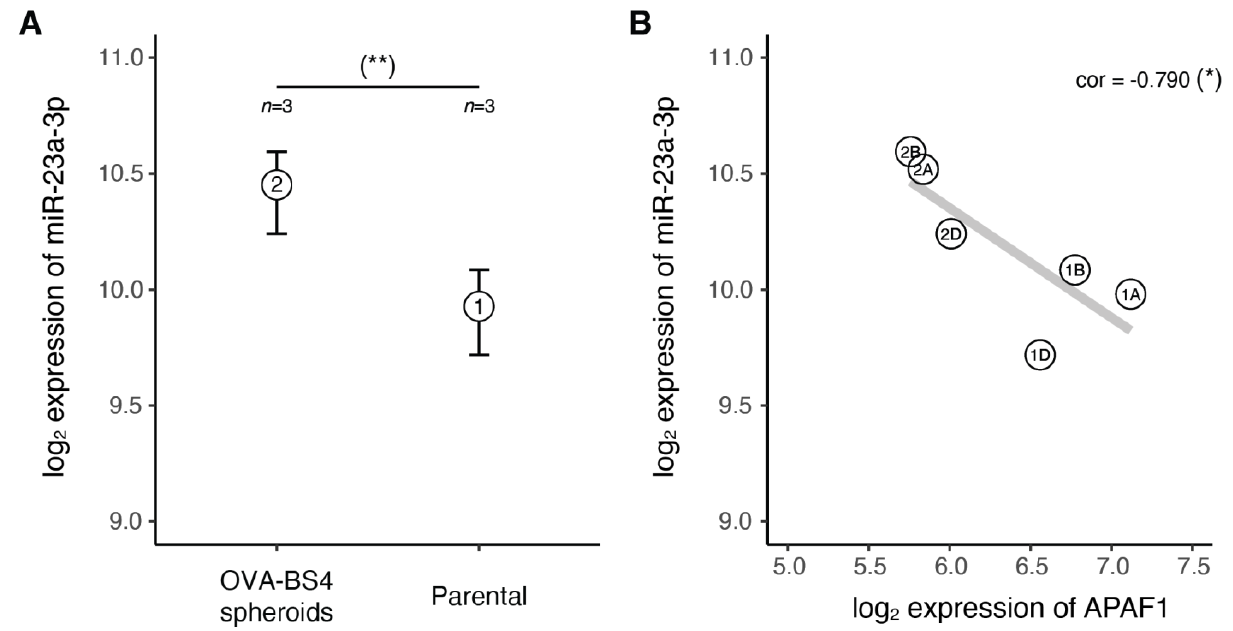
Figure 3. The miR-23a-3p in HGSOC-Stemlike cells. ( A ) Range (bars) and mean (points) for miR-23a-3p expression levels measured by microarray in stemlike cell replicates from OVA-BS4 spheroids (1) compared to the parental cell line replicates (2) ( p -value = 0.013, one-tail t -test). ( B ) Anti-correlation between miR-23a-3p and APAF1 expression levels measured by matched miRNA/gene microarray ( p -value = 0 .061, Pearson’s product -moment). (*) p ≤ 0.1, (**) p ≤ 0.05.